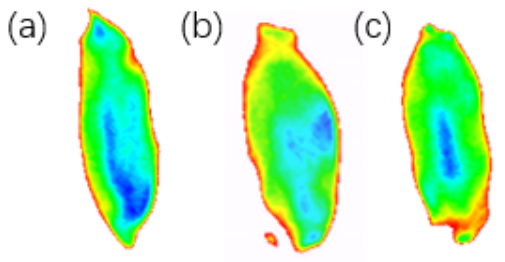
Figure 6. The THz spectral images of wheat after background removal. ( a ) Normal wheat; ( b ) moldy wheat; ( c ) sprouted wheat.